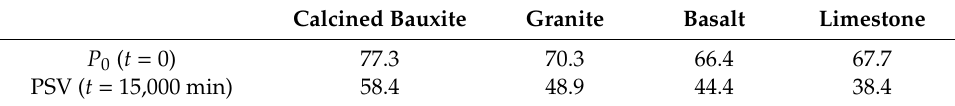
Table 4. Experimental PSV test results for the four aggregates (from [22]).